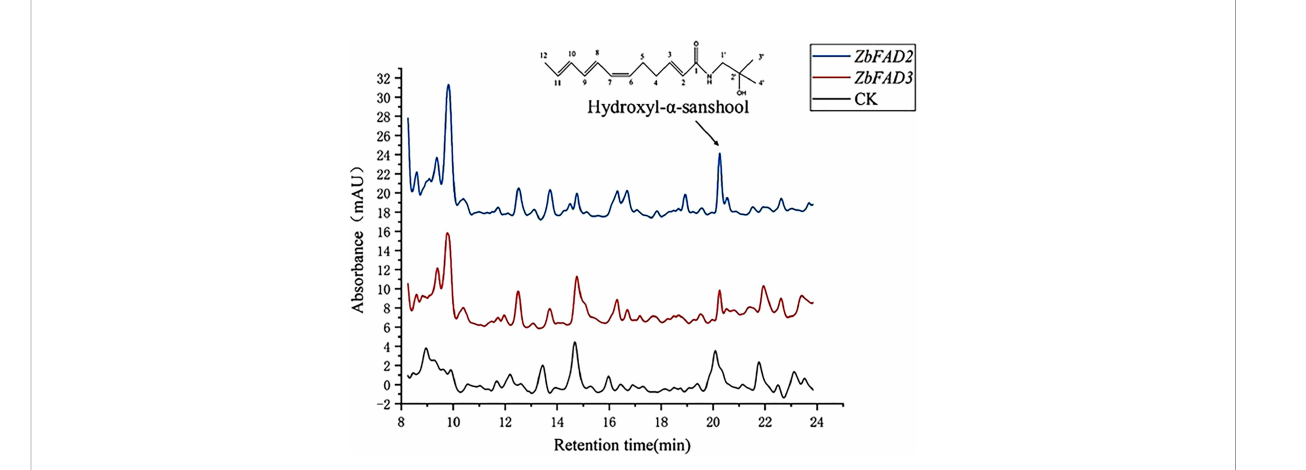
FIGURE 4 HPLC results of hydroxyl- a -sanshool in the ZbFAD3- and ZbFAD2 -transgenic N. benthamiana